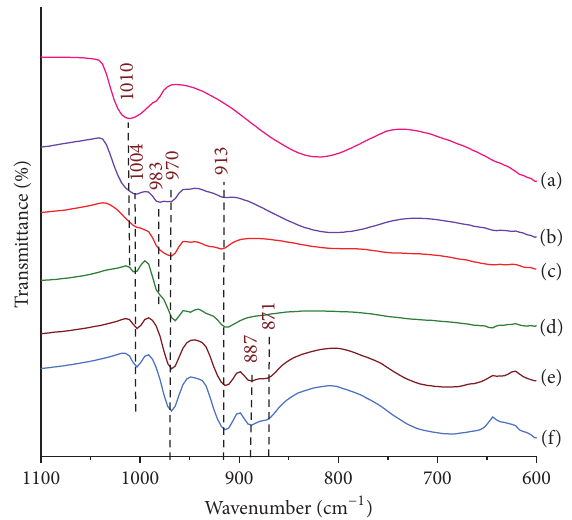
Figure 7: IR spectra of (a) V 2 O 5 , (b) V 2 O 5 -1Ag, (c) V 2 O 5 -5Ag, (d)